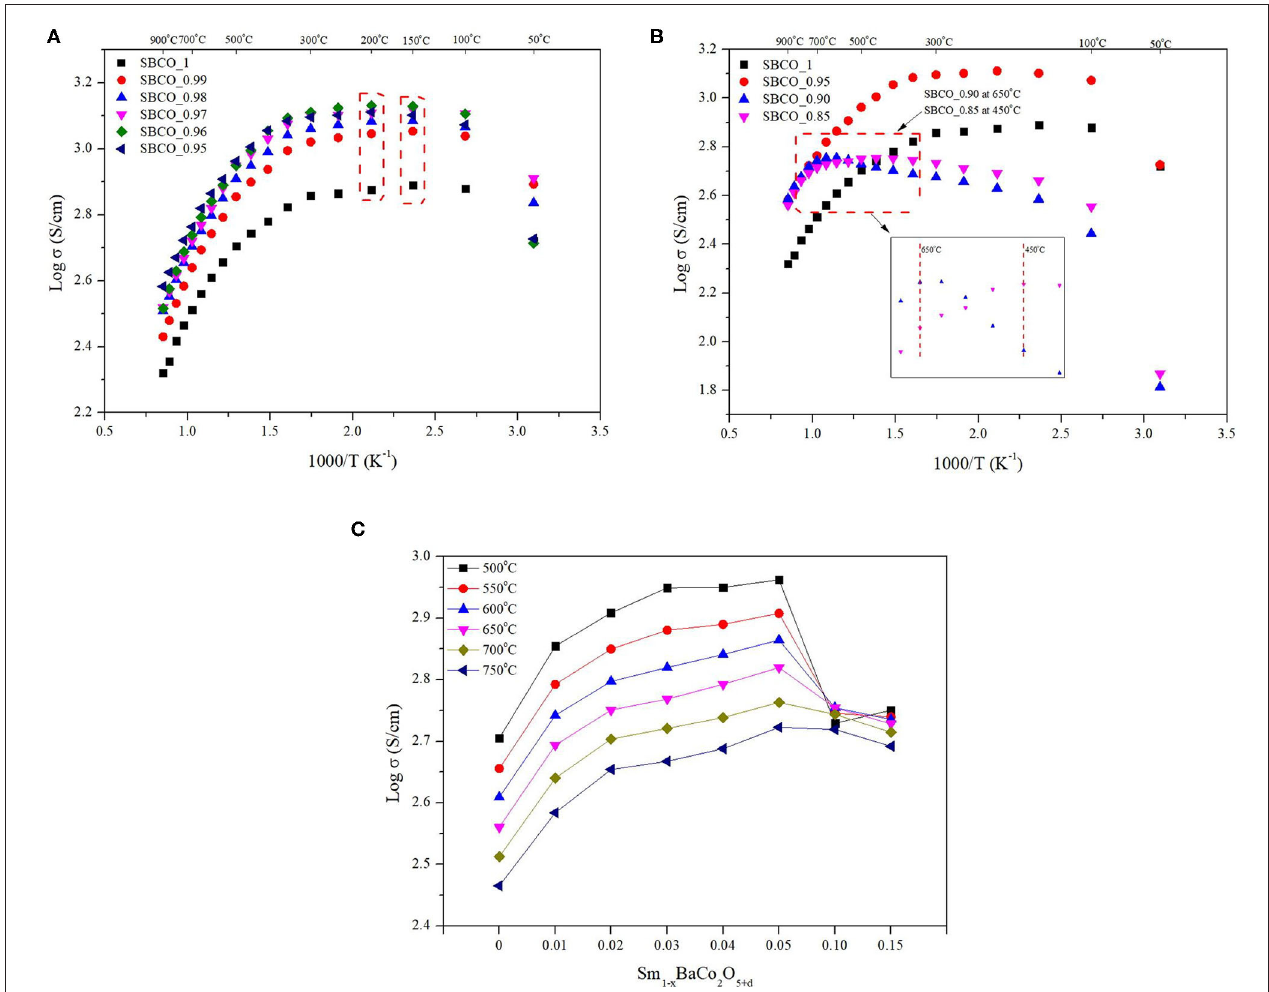
FIGURE 6 | Electrical conductivity results of Sm 1 − x BaCo 2 O 5 + d oxide systems cathode materials for each condition. (A) Electrical conductivity results of